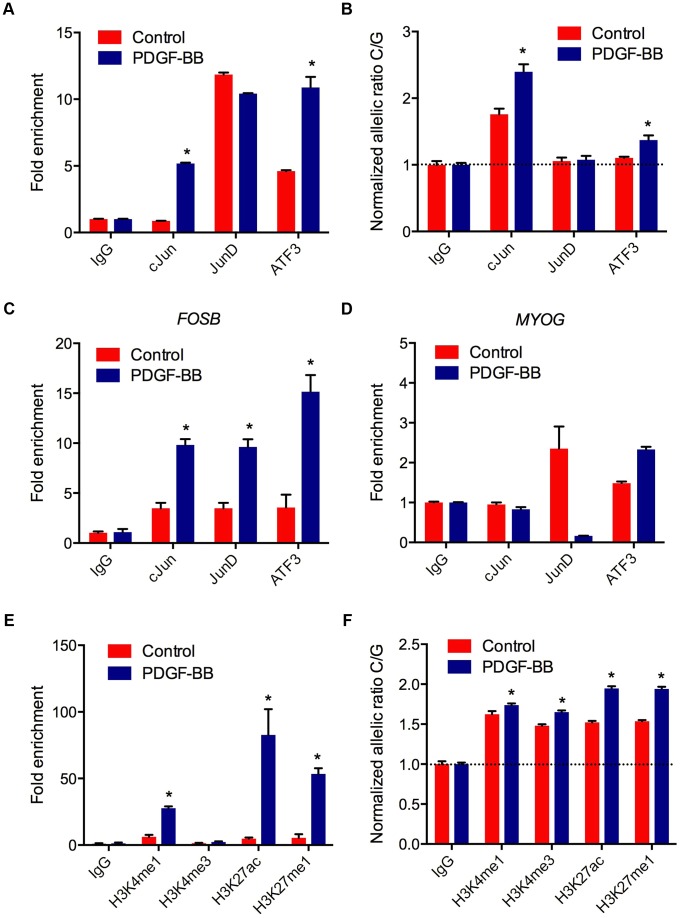
AP-1 mediated regulation at rs12190287 in vivo.(a) Total enrichment of c-Jun, JunD, and ATF3 at rs12190287 determined by chromatin immunoprecipitation (ChIP) in heterozygous HCASMC treated with PDGF-BB (20 ng/ml) or vehicle (Control) for 6 hrs. (b) Allele-specific enrichment of c-Jun, JunD and ATF3 at rs12190287 determined by HaploChIP in heterozygous HCASMC treated with PDGF-BB, shown as normalized allelic-ratio C/G. (c–d) AP-1 positive and negative control regions for c-Jun, JunD, and ATF3 enrichment at FOSB (c) and MYOG (d) promoters, respectively. (e) Total enrichment of histone modifications H3K4me1, H3K4me3, H3K27ac, and H3K27me1 at rs12190287 determined by ChIP in heterozygous HCASMC treated with PDGF-BB. (f) Allele-specific enrichment of H3K4me1, H3K4me3, H3K27ac, and H3K27me1 at rs12190287 determined by HaploChIP in heterozygous HCASMC treated with PDGF-BB, shown as normalized allelic ratio C/G. *P<0.001 versus Control for each condition. Values are mean ± SD from triplicates. Similar results were observed from 3–4 independent experiments. For HaploChIP experiments, separate heterozygous individual HCASMCs were used for each replicate experiment.